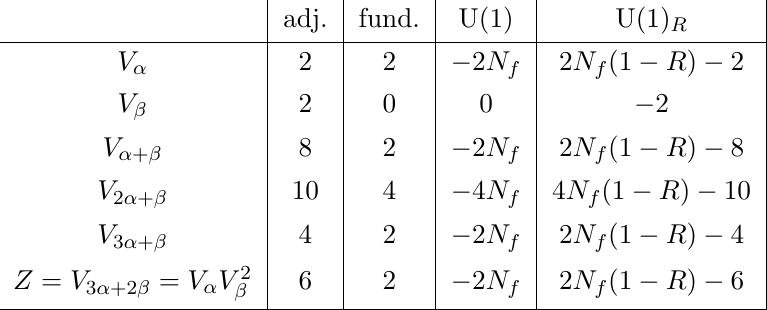
Table 4 . Zero-modes for Coulomb branch operators and global